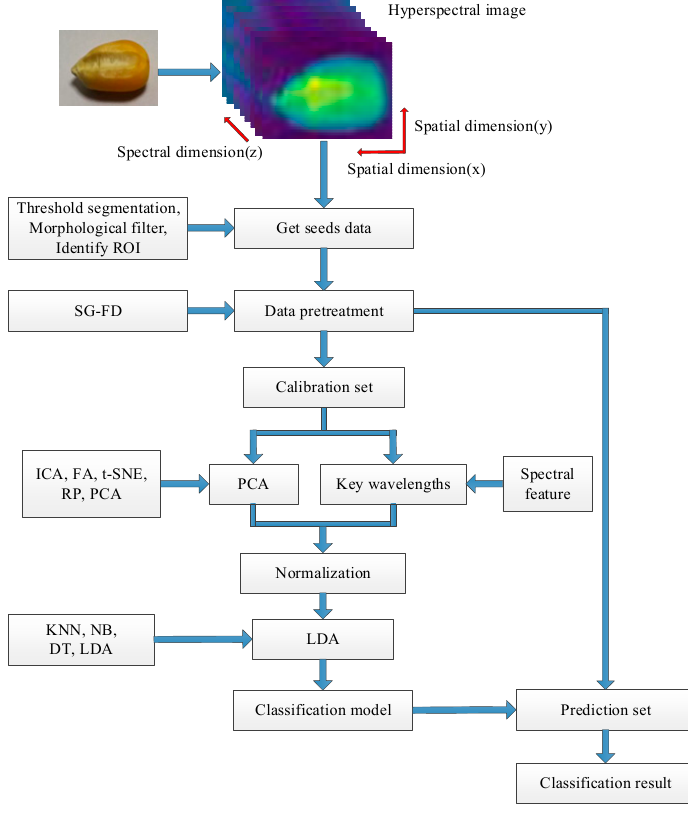
Figure 3. Flowchart of this